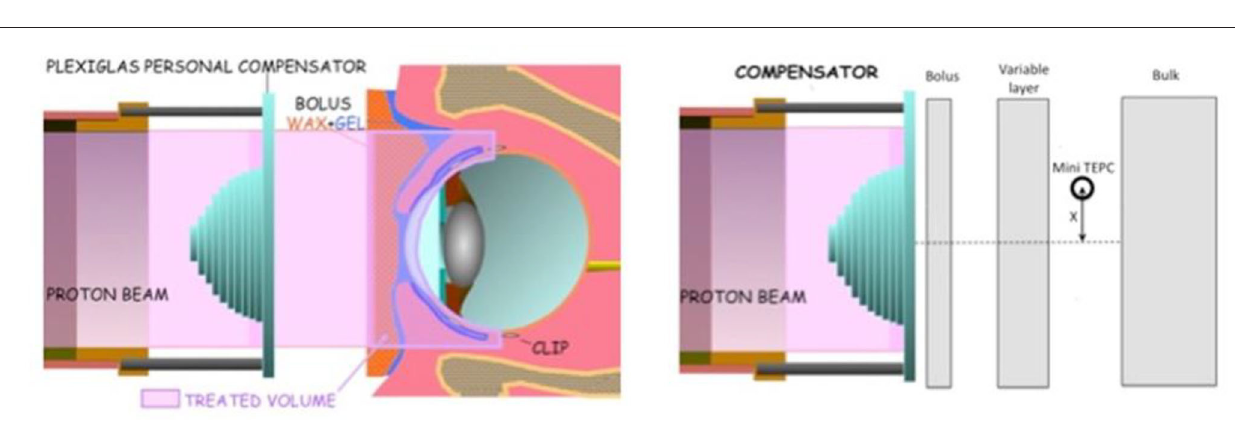
spectra collected with other detector types to provide, through equation (7), specific insights on the RBE of the tumor and healthy